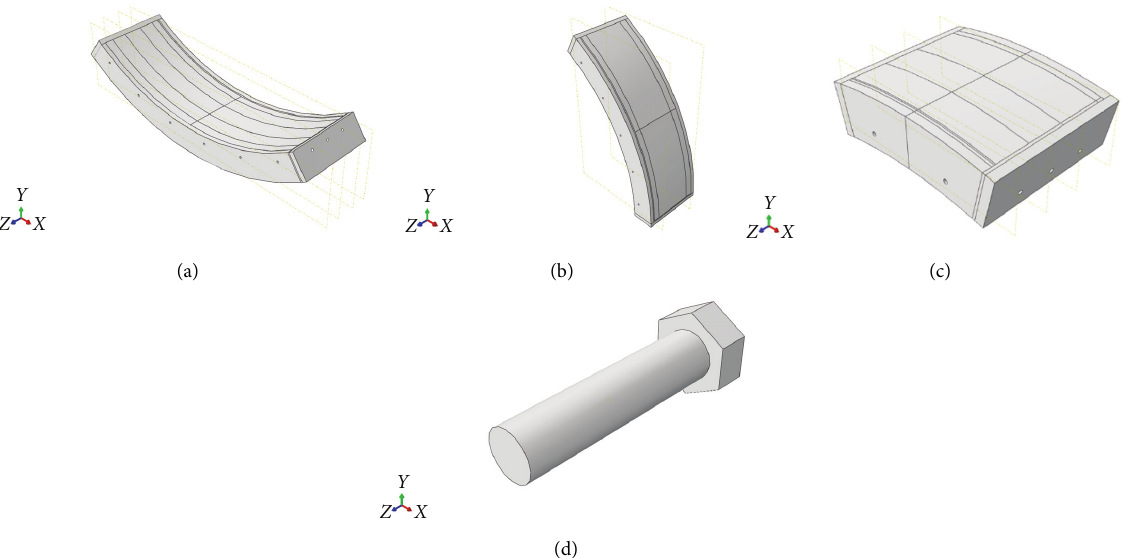
Figure 2: Numerical model of the shield tunnel lining. (a) The standard segment. (b) The adjacent segment. (c) The sealing-roof segment. (d) The bolt.